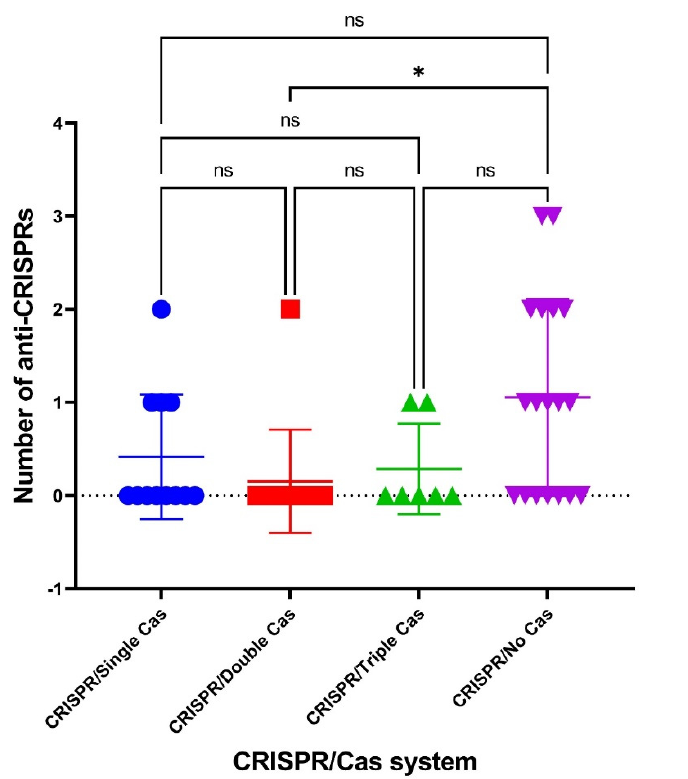
Figure 4. Anti-CRISPRs among the clinical CriePir P. aeruginosa isolates from a Moscow medical center with different CRISPR/Cas systems. * indicates the level of significance p < 0.05.